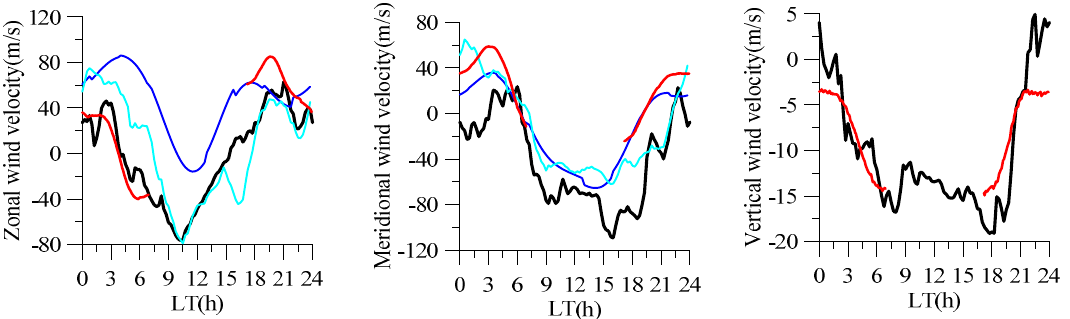
Figure 3. Wintertime diurnal variations in zonal ( positive eastward, left panel ), meridional ( positive southward, central panel ), and vertical ( positive upward, right panel ) winds obtained in various ways: The new method based on measurement of the group velocities of internal gravity waves (IGWs) ( black ), the Fabry–Pérot interferometer (FPI) ( red ), the HWM2007 ( blue ), and a previously developed method based on wind projection measurements ( cyan ).